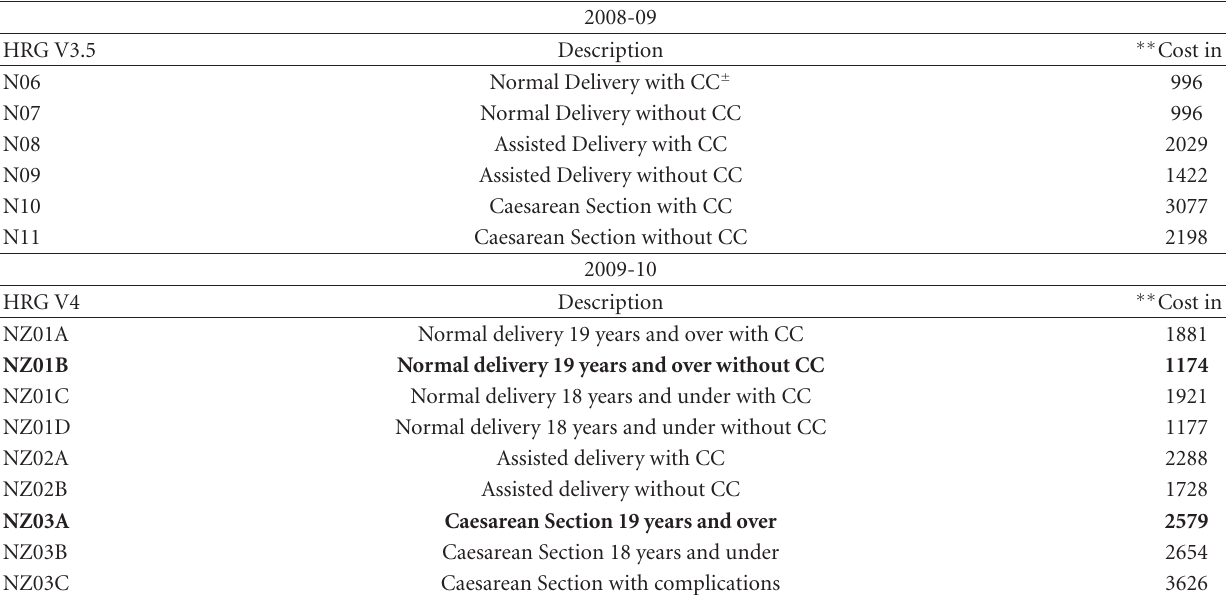
Table 5: Delivery Event National ± PbR Tari ff s 2008-09 & 2009-10 ⊥